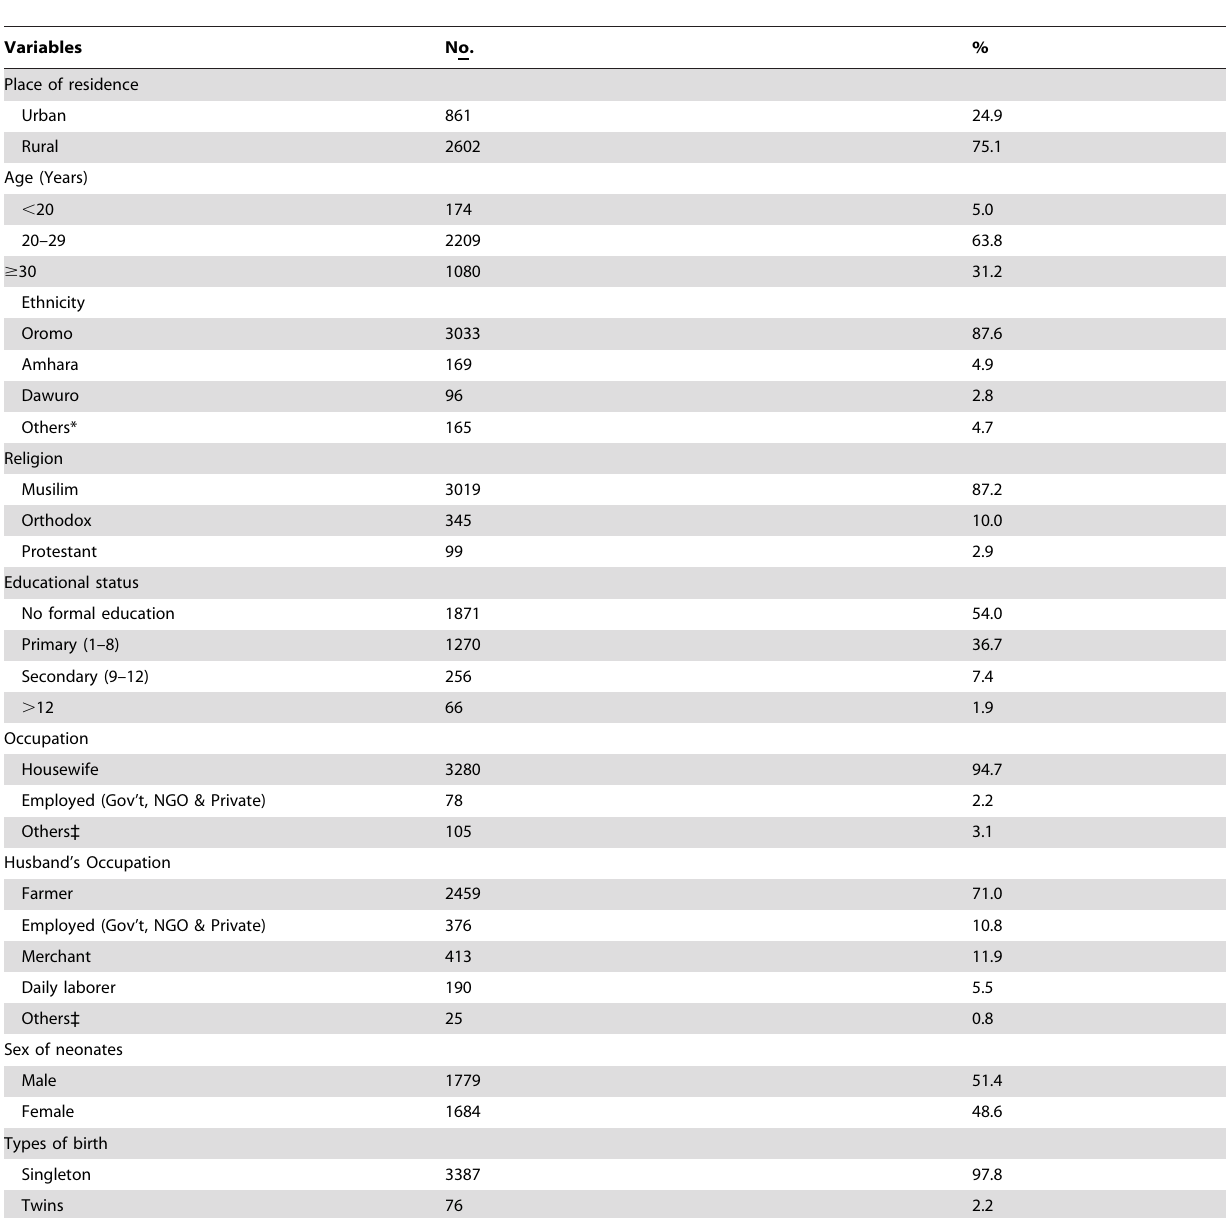
Table 2. Socio-Demographic characteristics of Respondents, Jimma Zone, Southwest Ethiopia, September 2012-December 2013